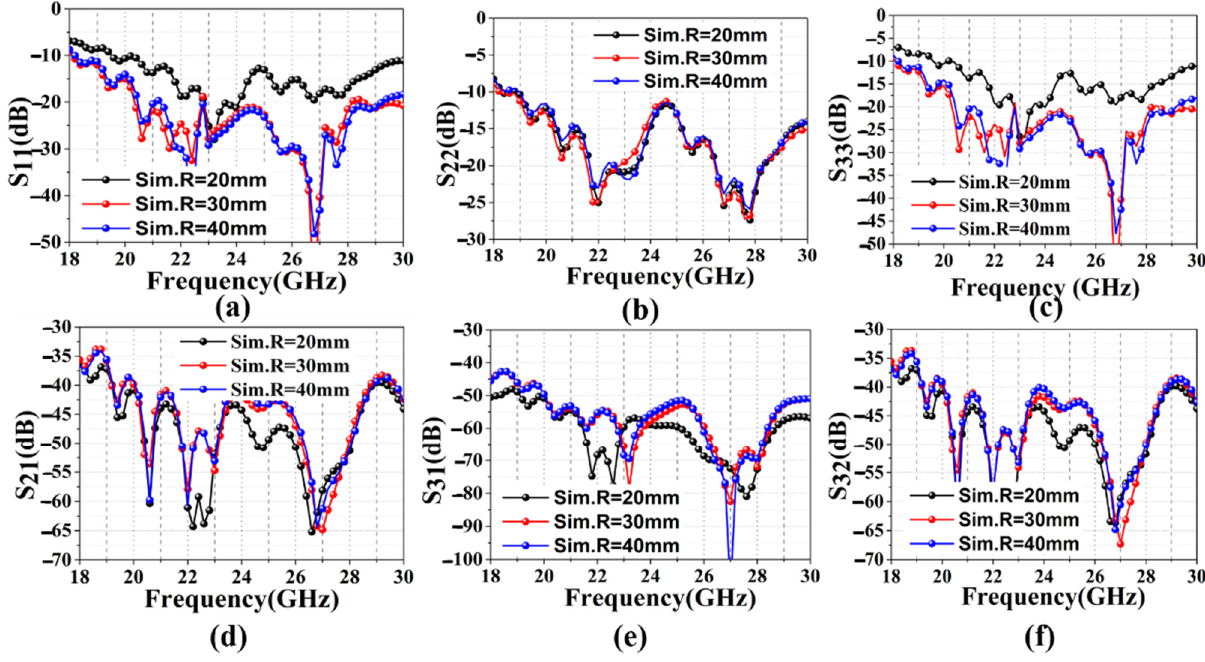
with the CGF antenna.